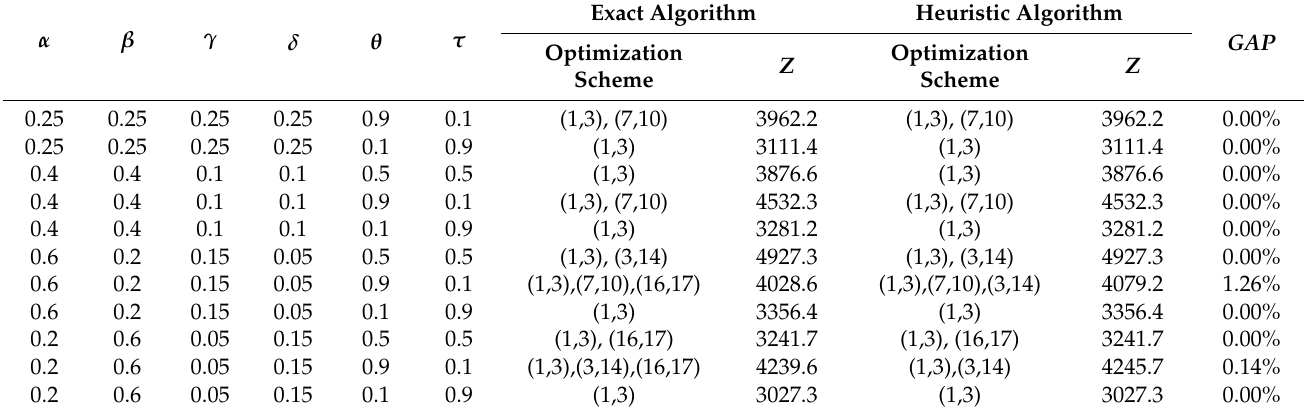
Table 8. Comparison between heuristic and exact algorithm under different weight coefficients. Exact